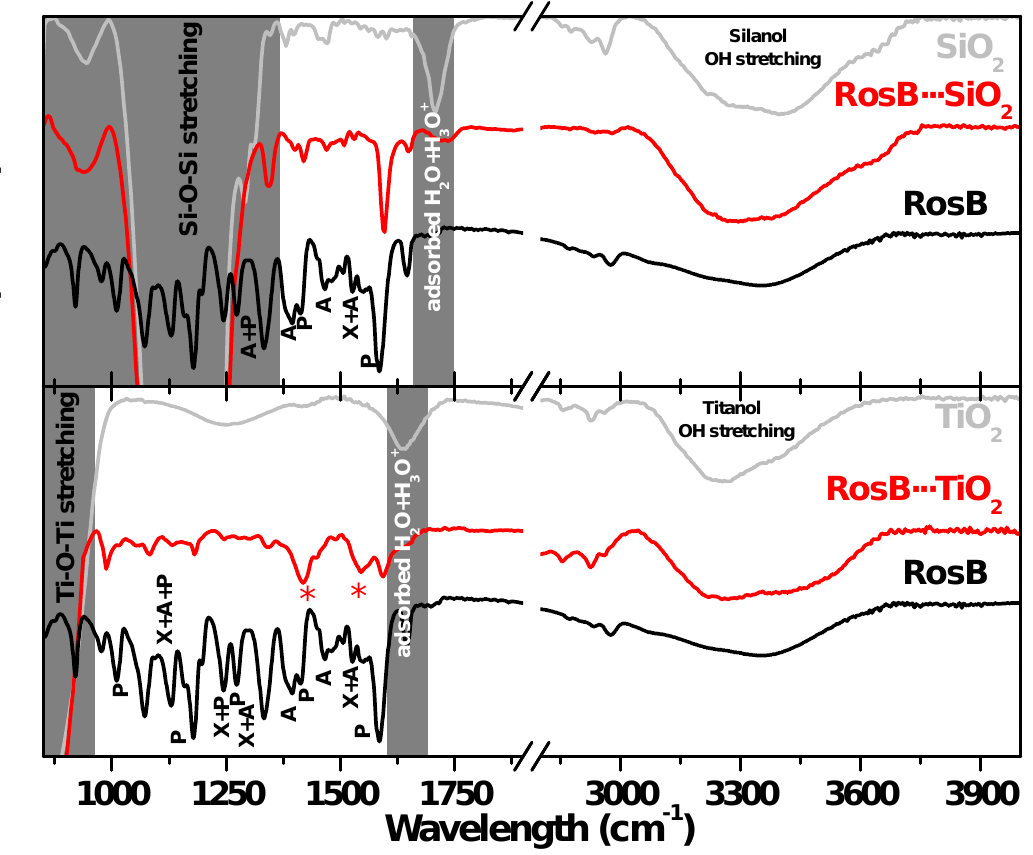
Figure 5. Specular reflectance Fourier Transform infrared spectra of MO 2 and RosB precursors compared with the bounded RosB · · · MO 2 in the devices. Vibration bands associated with phenyl ring (P). Amine (A) and xanthene ring (X) are indicated conveniently. See the main text for